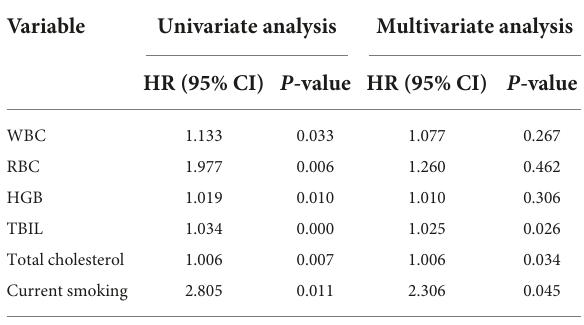
TABLE 5 Statistically significant results in Cox regression analyses for predictors of